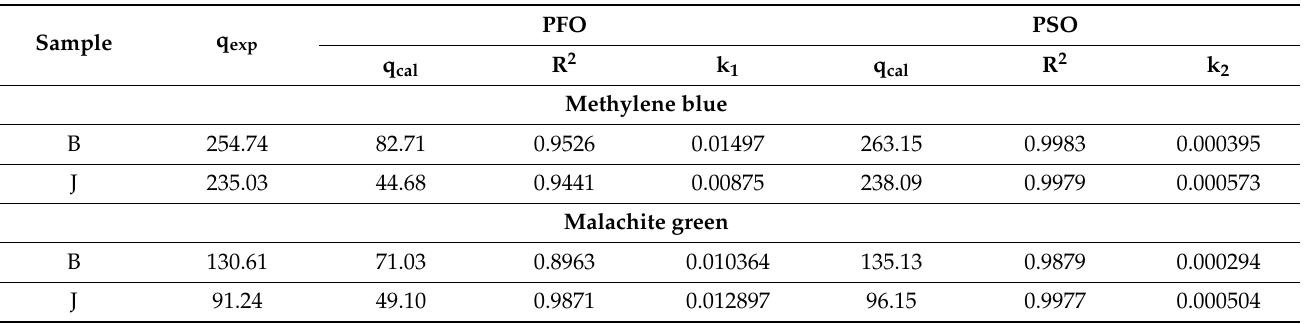
Table 4. Kinetic parameters for MB and MG adsorption on the carbonaceous materials derived from the used carbon filters.